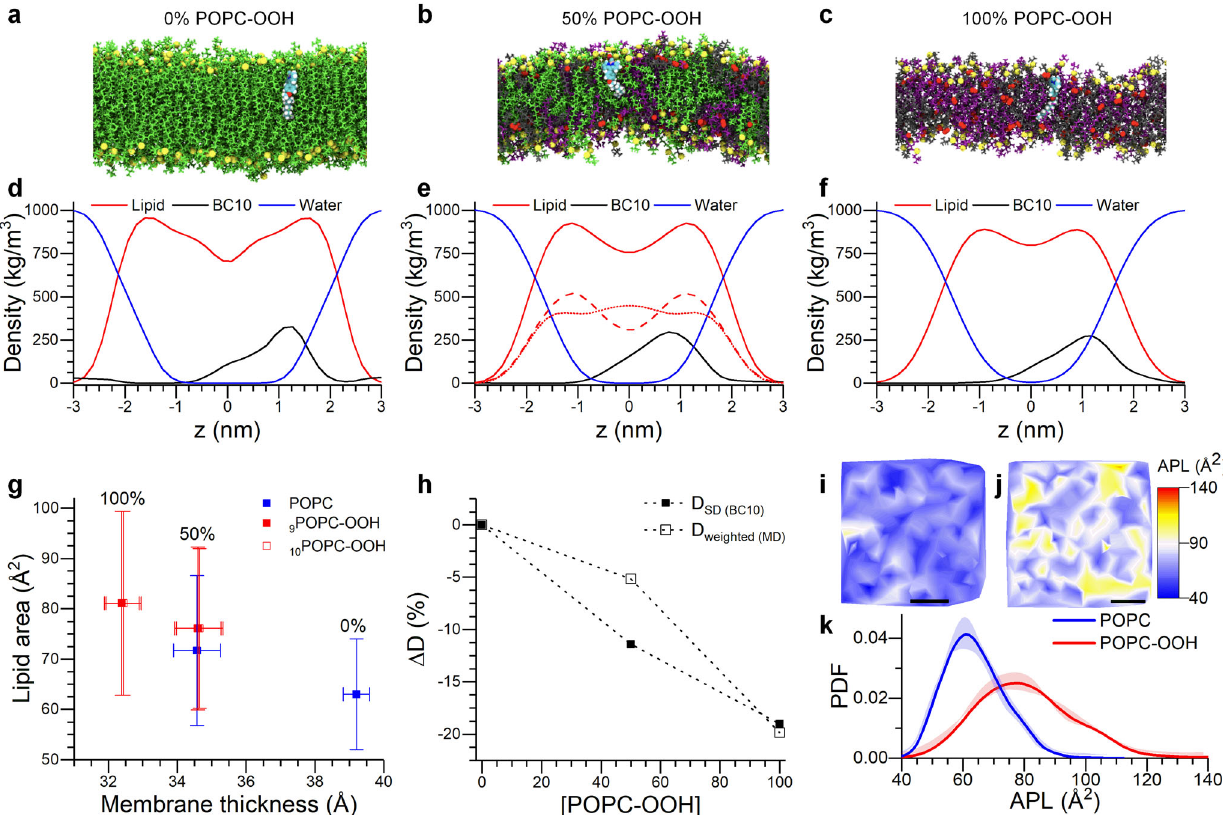
Fig. 6 MD simulations of POPC-OOH containing membranes. a – c Lateral snapshots of the simulated bilayers containing increasing amounts of POPC- OOH. Colour coding: Green-POPC, Gray-oxPOPC9, Purple-oxPOPC10 (see Fig. S15 for details), Yellow-Phosphorous, Red-Oxygen. BC10 is also shown (cyan), within the lea fl et regardless of the membrane ’ s composition, but closer to the phospholipid headgroups in the 100% POPC-OOH membrane. d , f Electron density pro fi les of membranes containing increasing amounts of POPC-OOH. In ( e ) the red traces correspond to all lipids (continuous trace), POPC (dotted) and POPC-OOH (dashed). g Area-thickness relationship for lipid peroxide containing bilayers. Data shown as mean ± S.D. from two independent simulations. h Relative variation of the 2-dimensional diffusion coef fi cient obtained from the MD simulations ( ⎕ ) and from molecular rotor data using the Saffman-Delbrück equation ( ∎ ). i , j Snapshots of a coarse-grained simulation showing the area per lipid (APL) maps of pure POPC ( i ) and POPC-OOH ( j ) membranes. Scalebar: 30 nm. k Bimodal APL distribution seen for the oxidized membranes ( j ), supporting the observation of lipid segregation in POPC-OOH